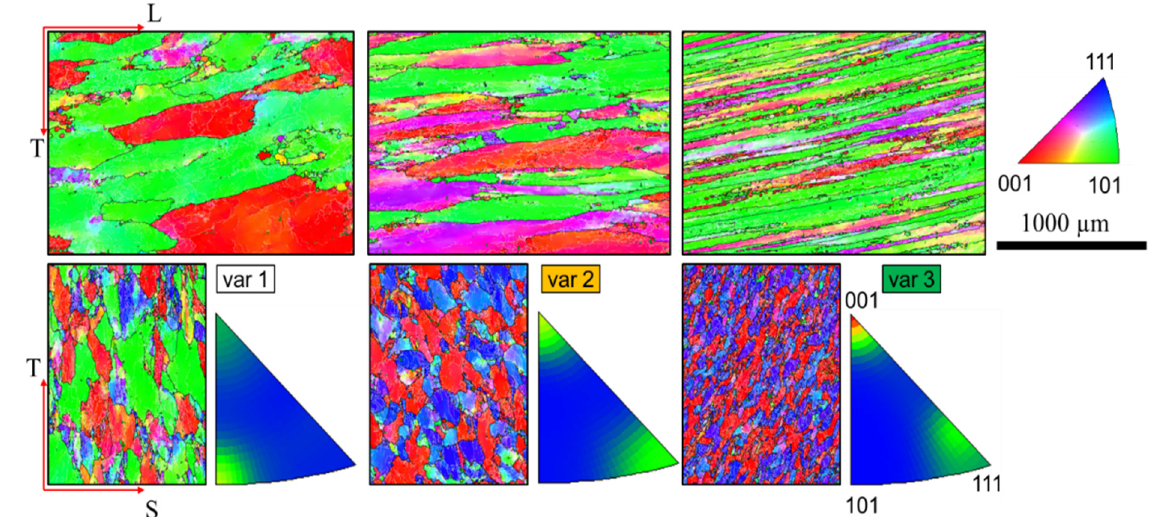
Figure 2. Inverse pole figure EBSD mapping showing the grain structure with high angle grain boundaries > 15° for the AA7010-T7452 var 1 to var 3, respectively. The colors indicate the crystallographic direction normal to the material’s plane shown, i.e., the colors for the L-T-plane (top row) show the crystallographic direction parallel to S. Readers are highly recommended to read the pdf version of the article for color visualizations.